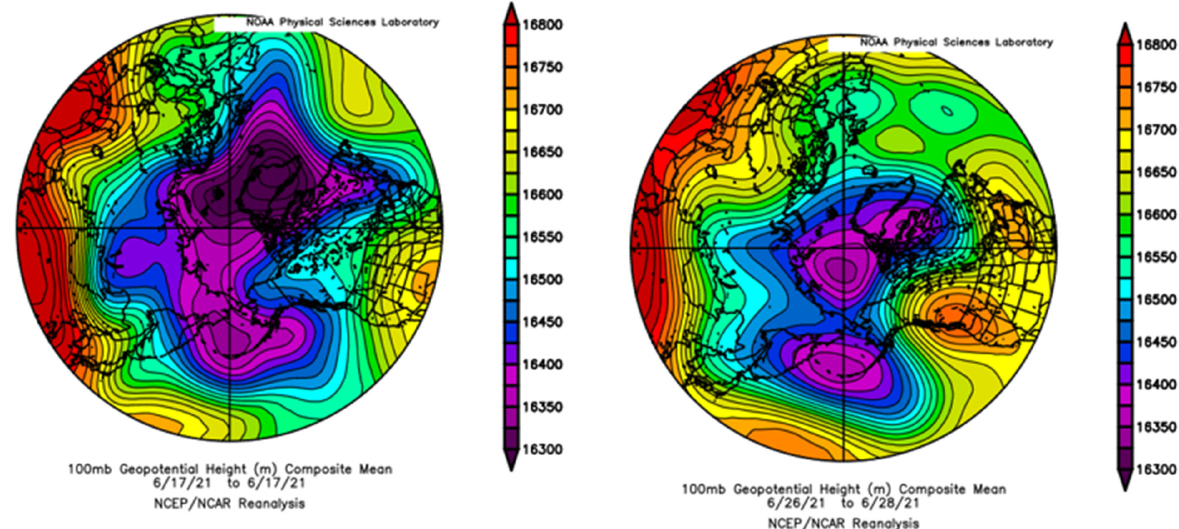
Figure 2. Geopotential height field at polar vortex level (100 hPa) at the beginning of the event (17 June 2021, left ) and during the main impact on the Pacific Northwest (26–28 June 2021, right ). Note that the legend is the same for both maps. Images are from NOAA/ESRL plotting routines based on the NCEP/NCAR reanalysis.